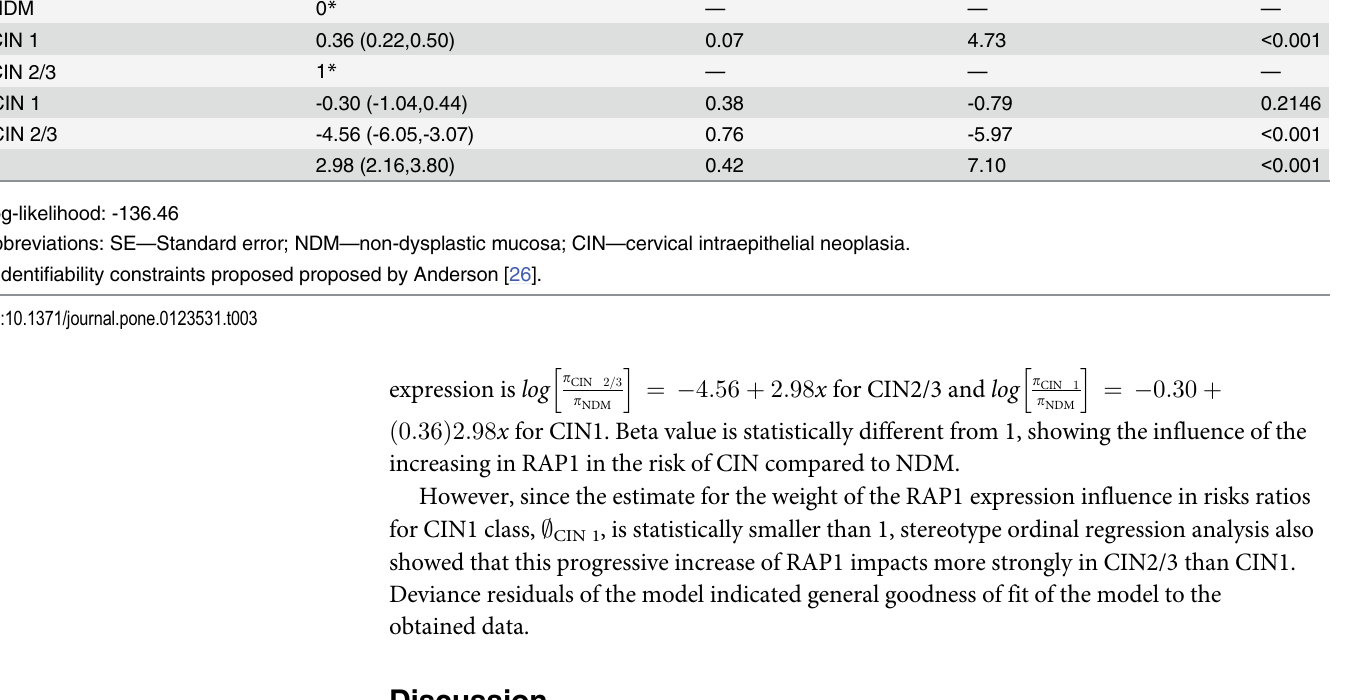
Table 3. Estimated coefficients, standard errors, z-scores, and two-tailed p -values for the fitted stereotype regression model. Coef fi